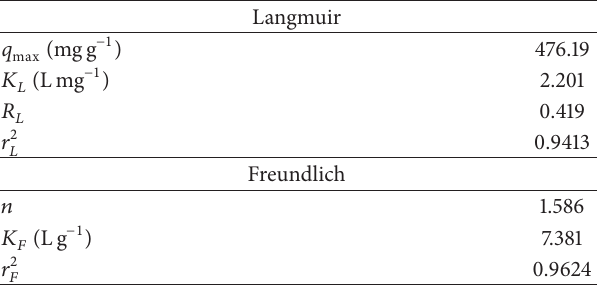
Table 3: Adsorption isotherms constants for the adsorption of lead (II) ions onto the activated carbon (SAC2) at 298.15